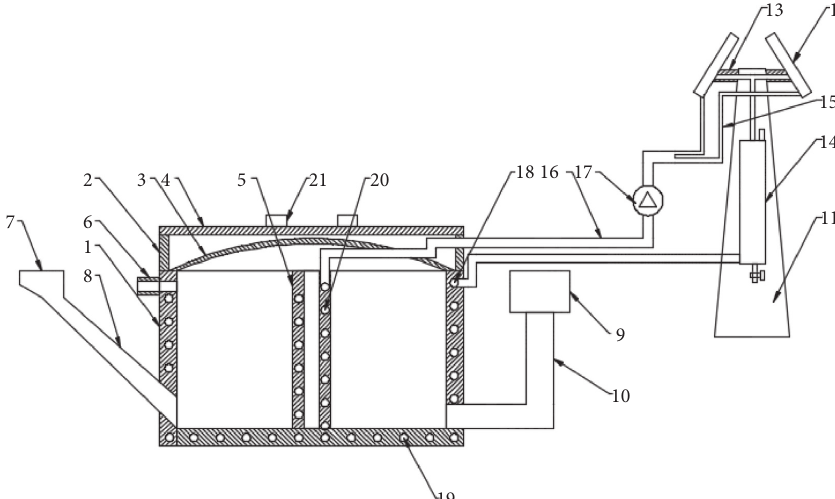
Figure 5: Design drawing of a new constant temperature biogas digester based on renewable energy. Chart source: the authors. 1: biogas digester, 2: heightening sealing edge, 3: inner sealing cover, 4: outer sealing cover, 5: central column, 6: biogas outlet pipe, 7: feeding port, 8: feeding pipe, 9: overflow port, 10: overflow pipe, 11: high tower, 12: solar collector, 13: support, 14: insulation water tank, 15: first water pipe, 16: second water pipe, 17: water pump, 18: first heating pipe, 19: second heating pipe, 20: third heating pipe, and 21: handle.